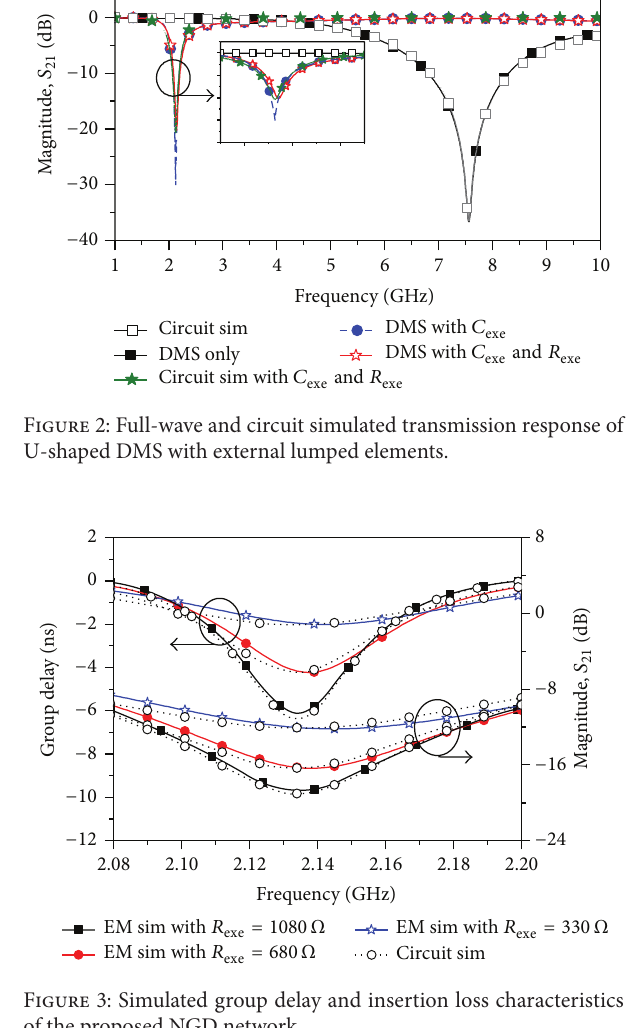
Figure 3: Simulated group delay and insertion loss characteristics of the proposed NGD network.